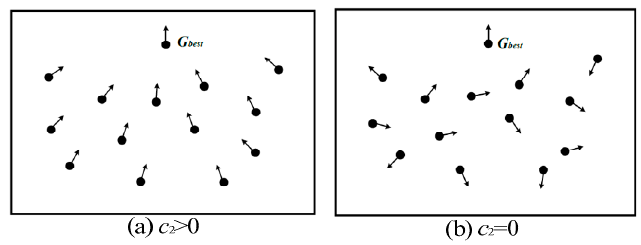
Figure 4. Convergence speeds of PSO and AVURPSO algorithms.